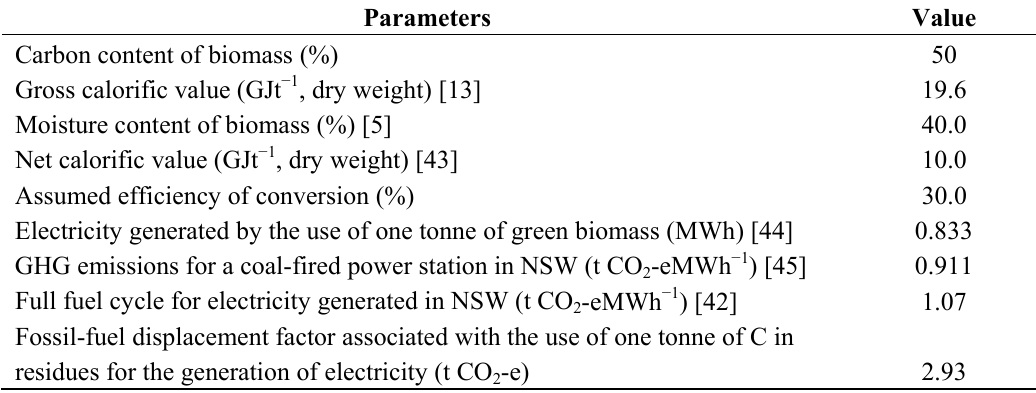
Table 7. Use of harvest residues for energy generation—key